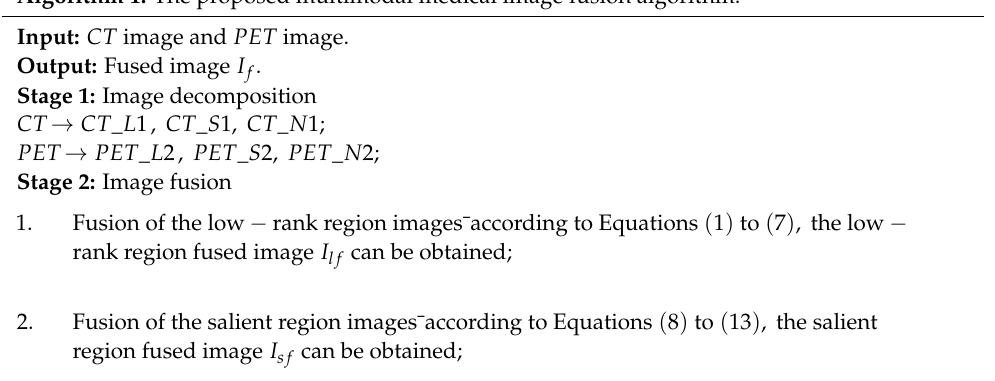
Algorithm 1. The proposed multimodal medical image fusion